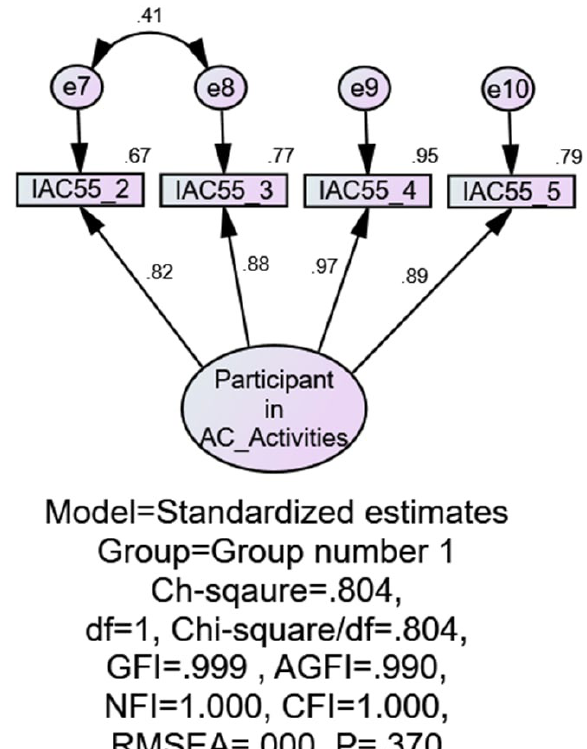
Figure A1. The first-order factor model.